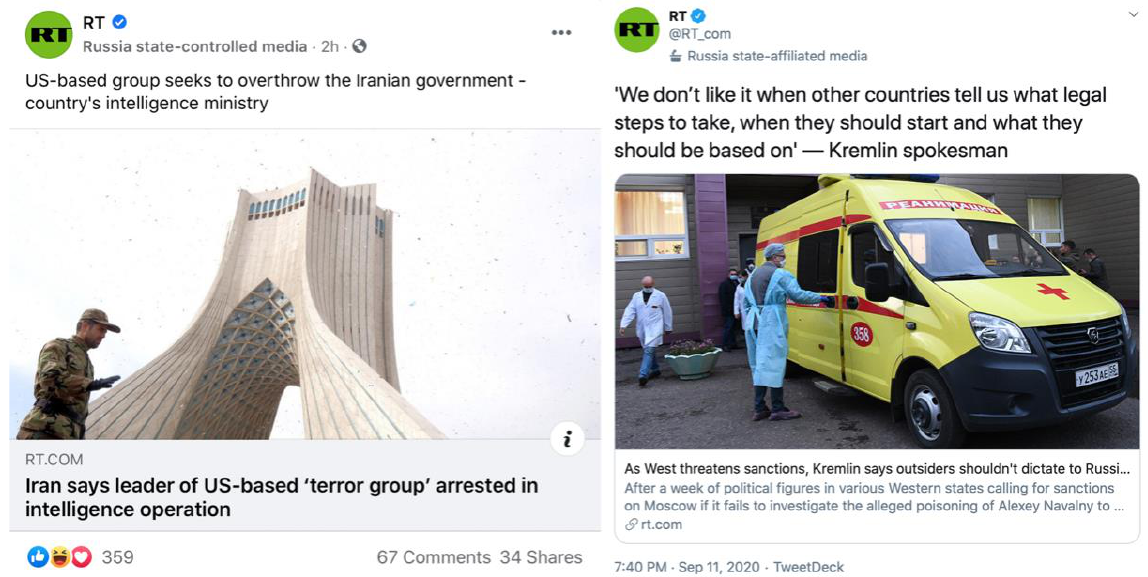
Figure 2. Different implementations of state-media labeling on Facebook (left) and Twitter